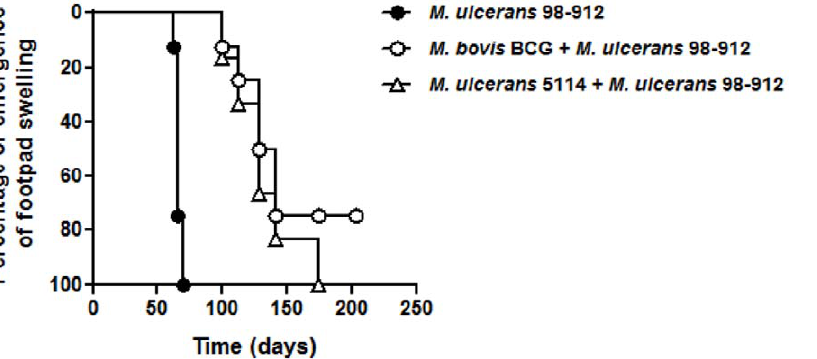
N Figure 5. Immunization with BCG or mycolactone-negative M.ulcerans delays the onset of footpad swelling after challenge with a ) or immunized with BCG ( # ) or with M. ulcerans 5114 ( n ) two months low dose of virulent M.ulcerans . Mice were either non-immunized ( before challenge. All mice were infected in the footpad with 2 log 10 CFU of M. ulcerans 98–912. Footpad swelling was monitored throughout the experimental infection ( n =10). Initial footpad swelling was considered at 2.60 mm, after which mice progressed to ulceration of the footpad. For ethical reasons, mice were sacrificed upon onset of footpad ulceration. doi:10.1371/journal.pone.0033406.g005 PLoS ONE |